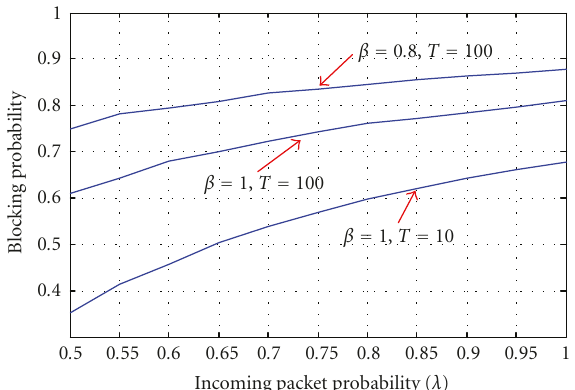
Figure 7: Blocking probability versus incoming packet probability ( β = 0 . 8,1 . 0).